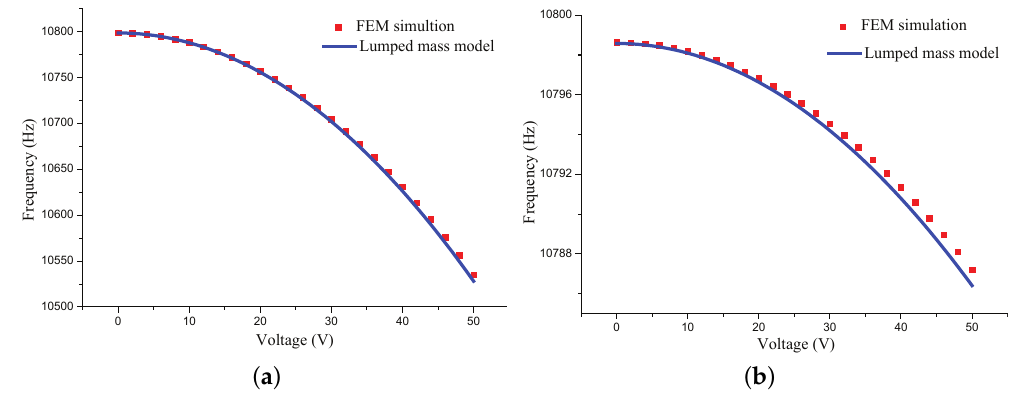
Figure 9. Modal frequency softening of the working modes of the MRR. ( a ) Frequency of the cosine mode. ( b ) Frequency of the sine